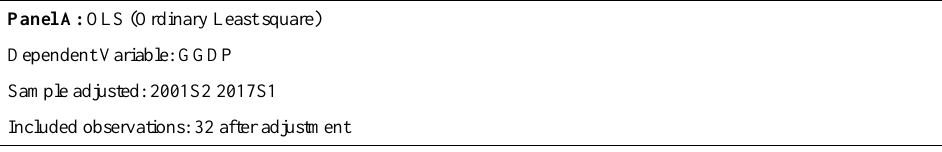
Table 5. Using OLS to estimate diagnostic